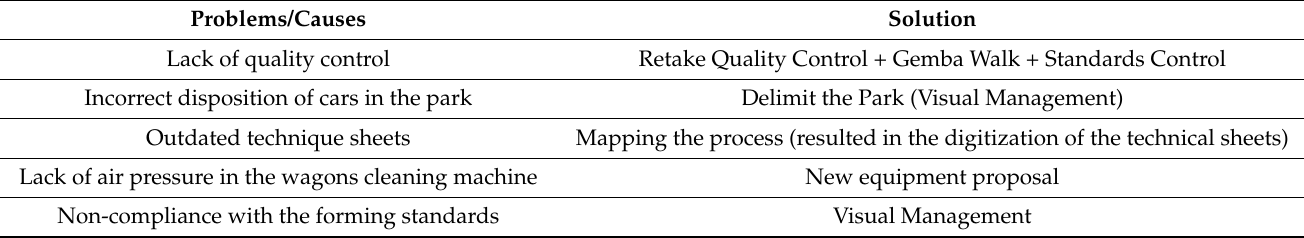
Table 5. Problems and